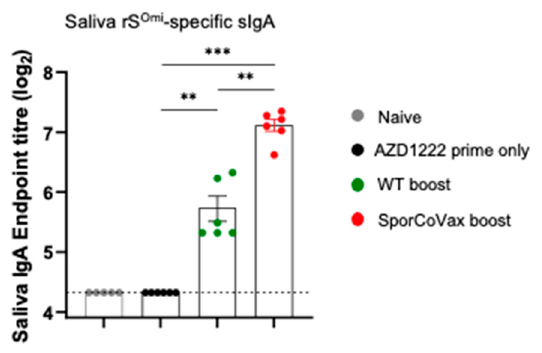
Figure 3. Spore-induced mucosal Spike-specific sIgA cross-reacts with Wuhan and Omicron variants. Mice were primed (i.m.) with 1.0 × 10 8 IU of AZD1222 followed by two intranasal boosts with spores (1 × 10 9 CFU) of WT (naked) or SporCoVax (1:1 mixture of CotB-RBD Wuh and CotC-HR1-HR2 Wuh spores) at three and five weeks post prime. rS Omi -specific sIgA in the saliva 48 days post immunization is shown. Mann–Whitney, ** p < 0.01, *** p < 0.001.